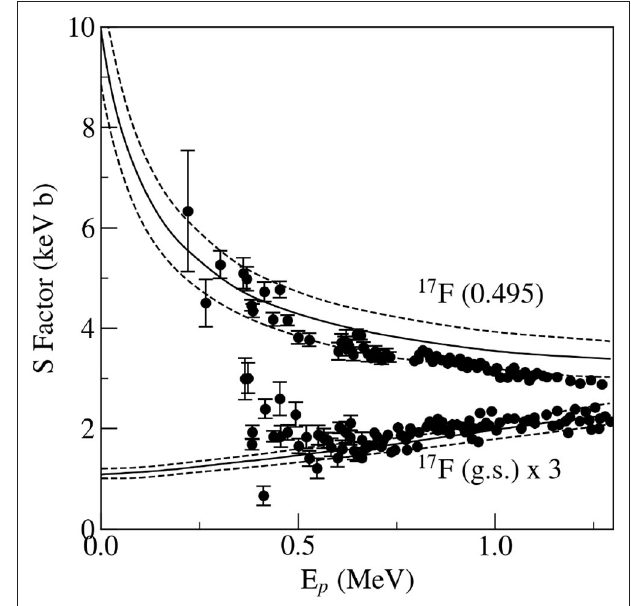
FIGURE 4 | Angular distributions for the ground and first excited states of 17 F from the 16 O( 3 He,d) 17 F reaction. The dashed and solid curves are DWBA fits using two optical model potential parameter sets (Gagliardi et al., 1999).